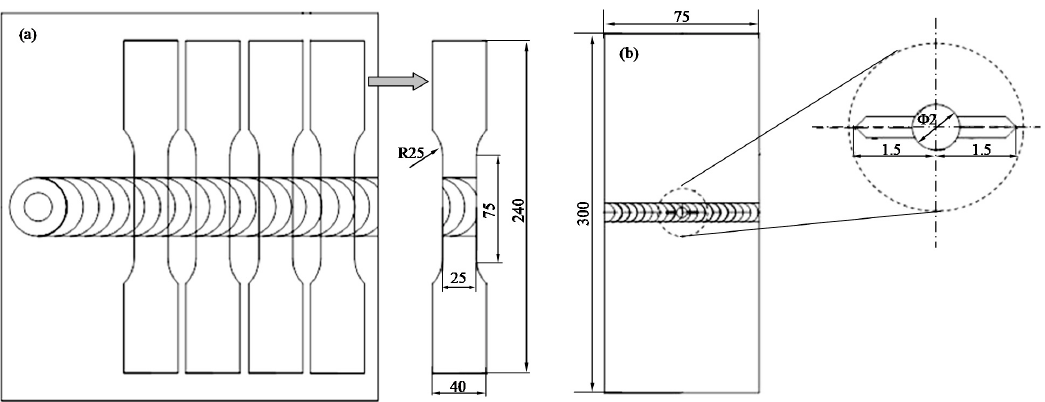
Figure 3. Schematic illustration of ( a ) fatigue and ( b ) crack propagation specimens.